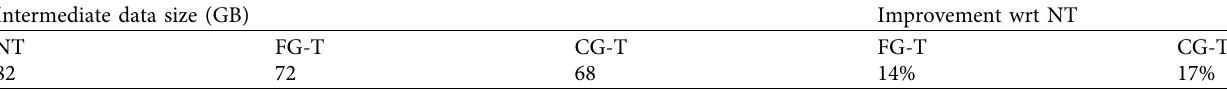
Table 6: Total intermediate data size of shared two-way join queries in Hadoop MapReduce.